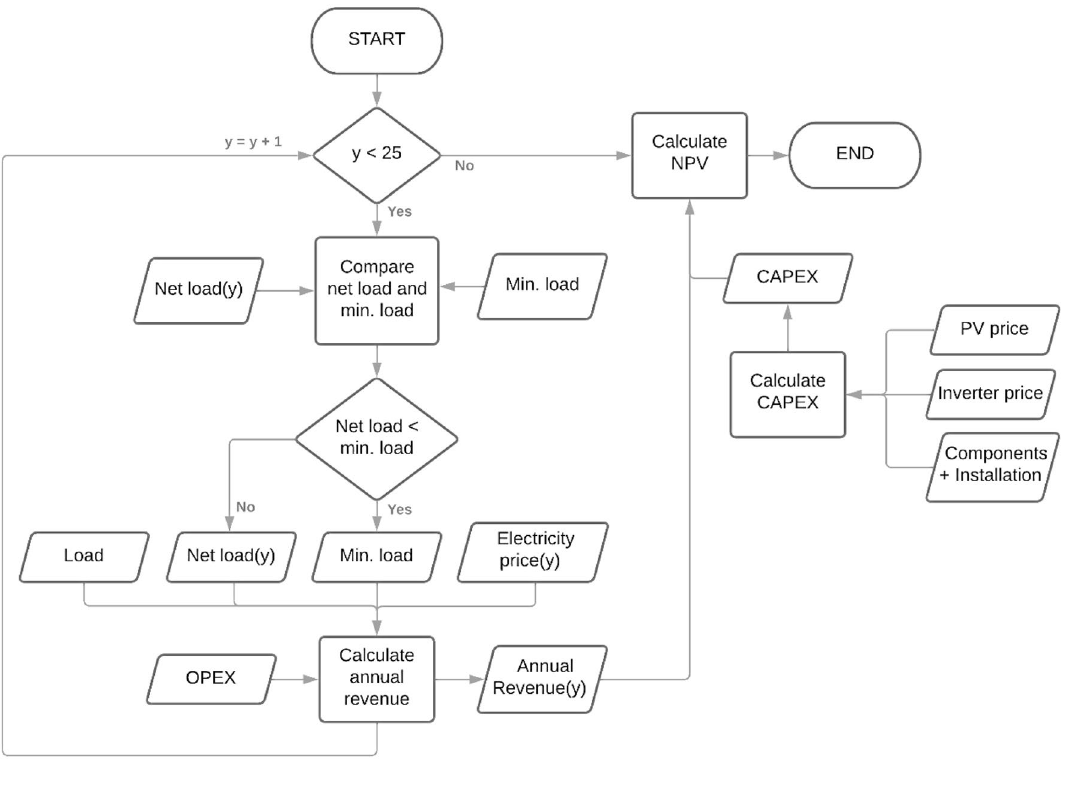
Figure 5. RSPP financial